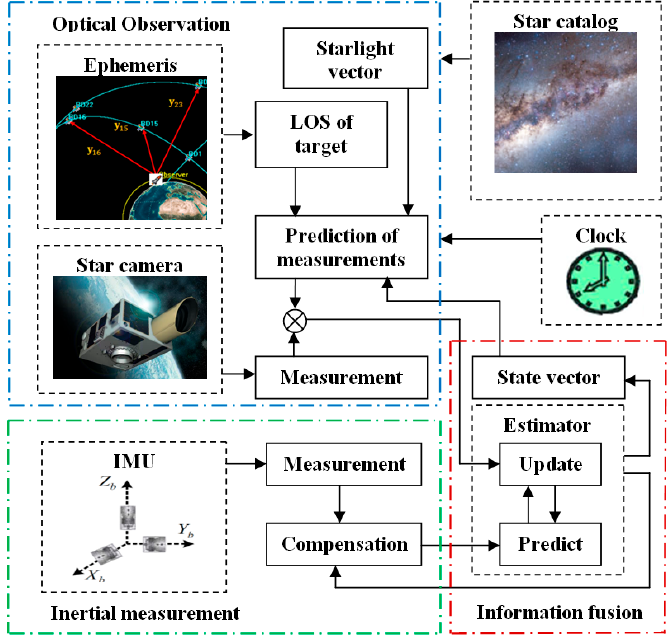
Figure 2. Space-target-based INS/Vision integrated navigation method.